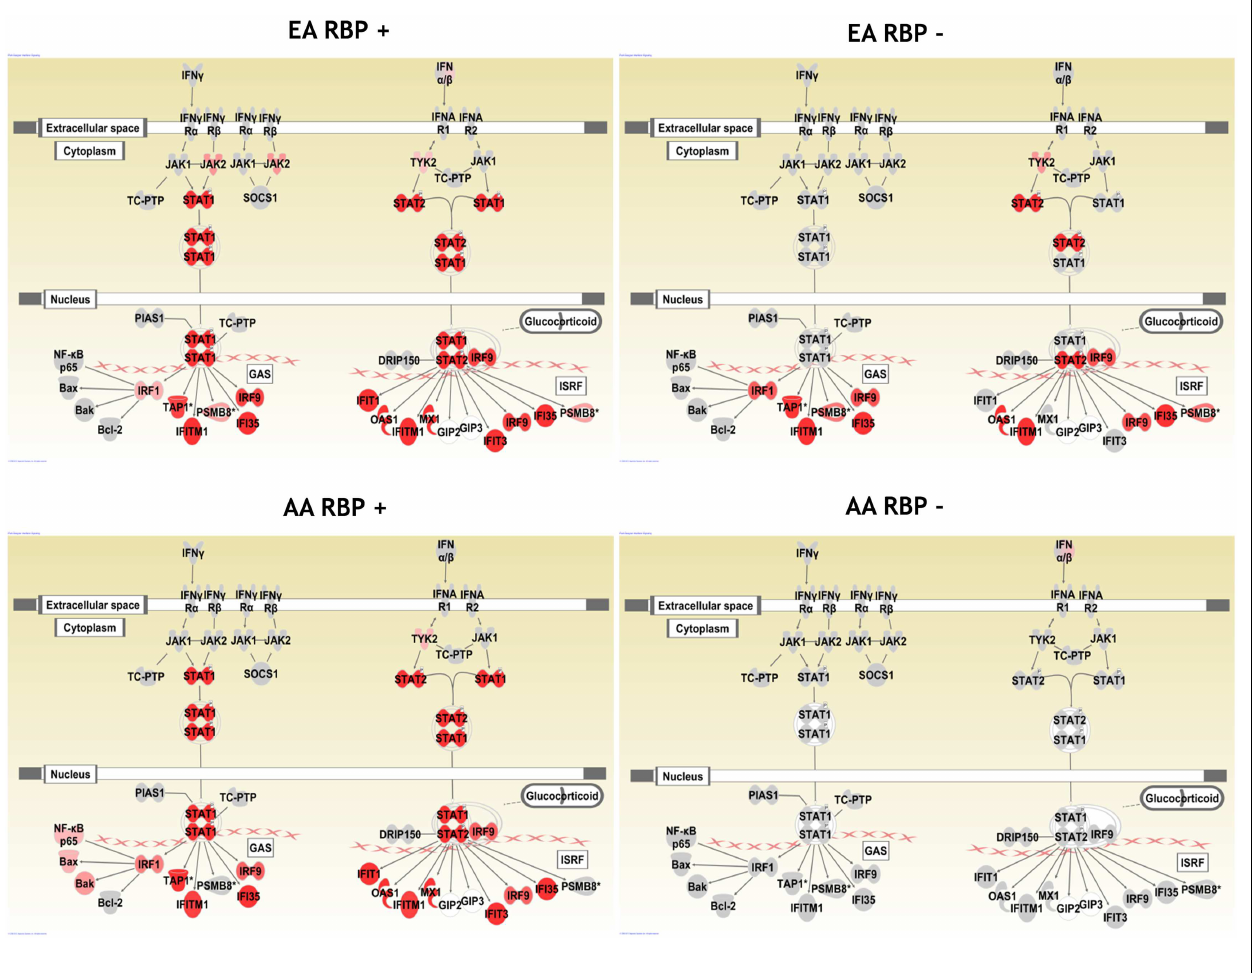
FIGURE 1 | Pathway diagram illustrating the type I and type II IFN pathways in SLE patient subsets . Genes which are up-regulated are shaded red, with increasingly dark red shading indicating a greater degree of over-expression in cases as compared to controls of the same